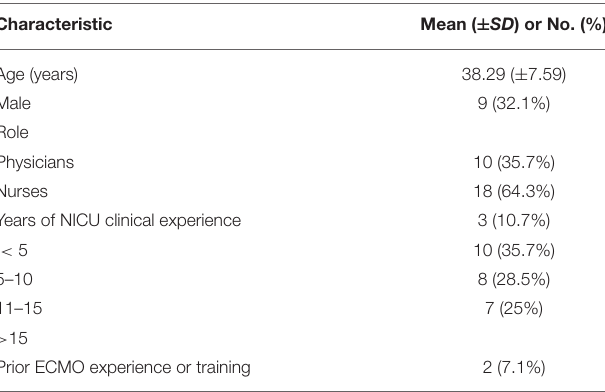
TABLE 2 | Demographic data of trainees undergoing ECMO educational